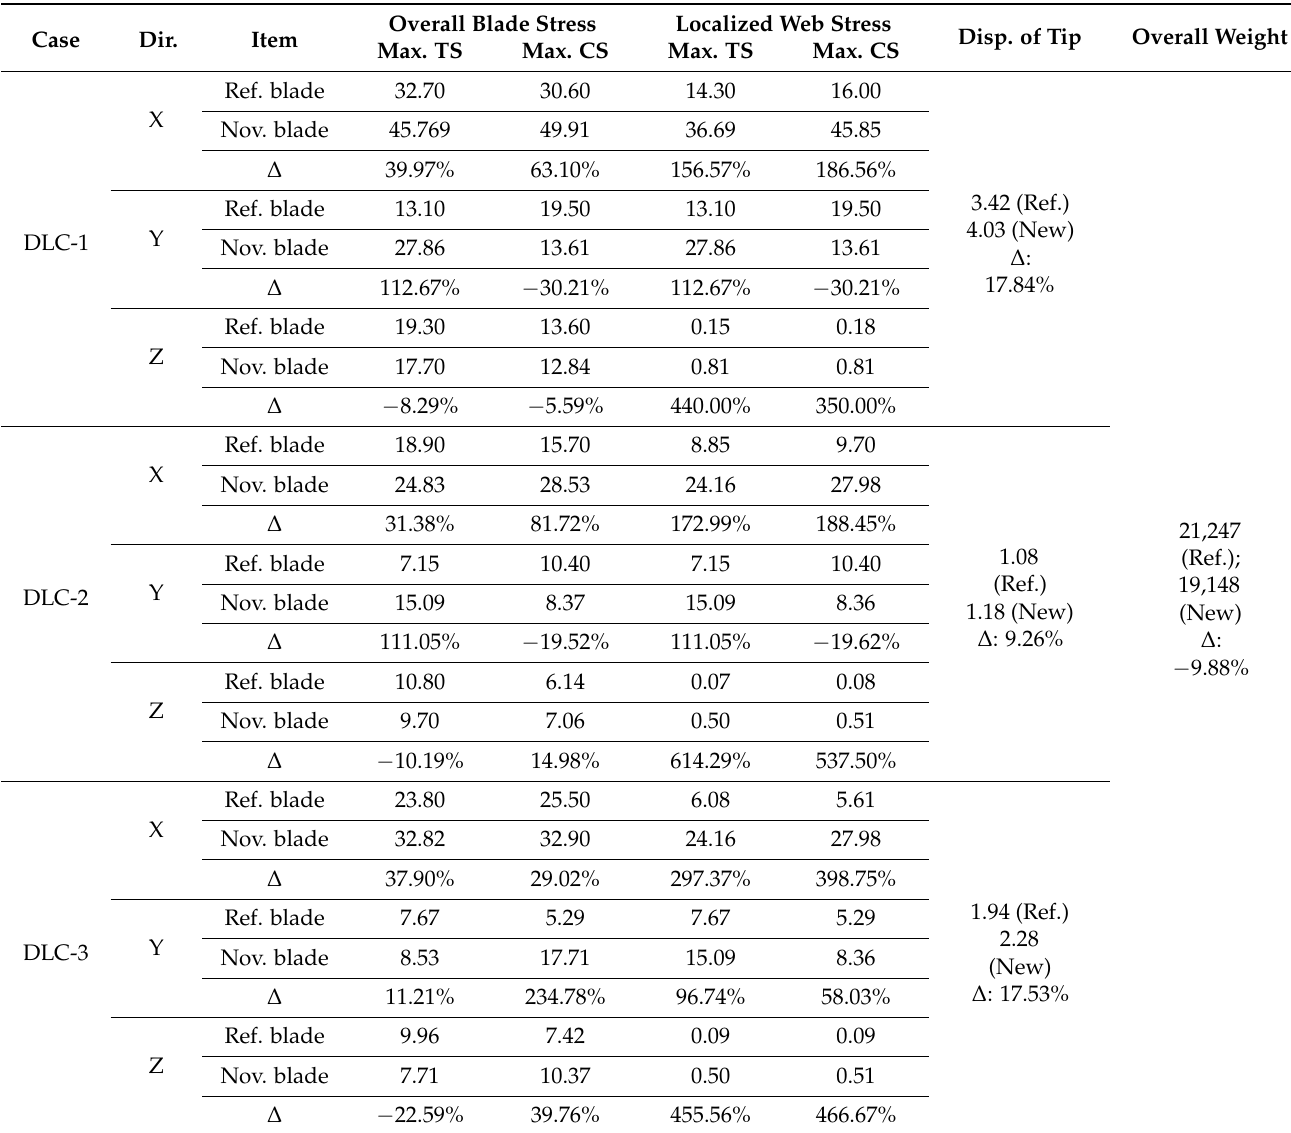
Table 8. Compared results of performance indexes between the novel and reference turbine blades. Unit in stress: MPa, in displacement of tip: m, in overall weight: